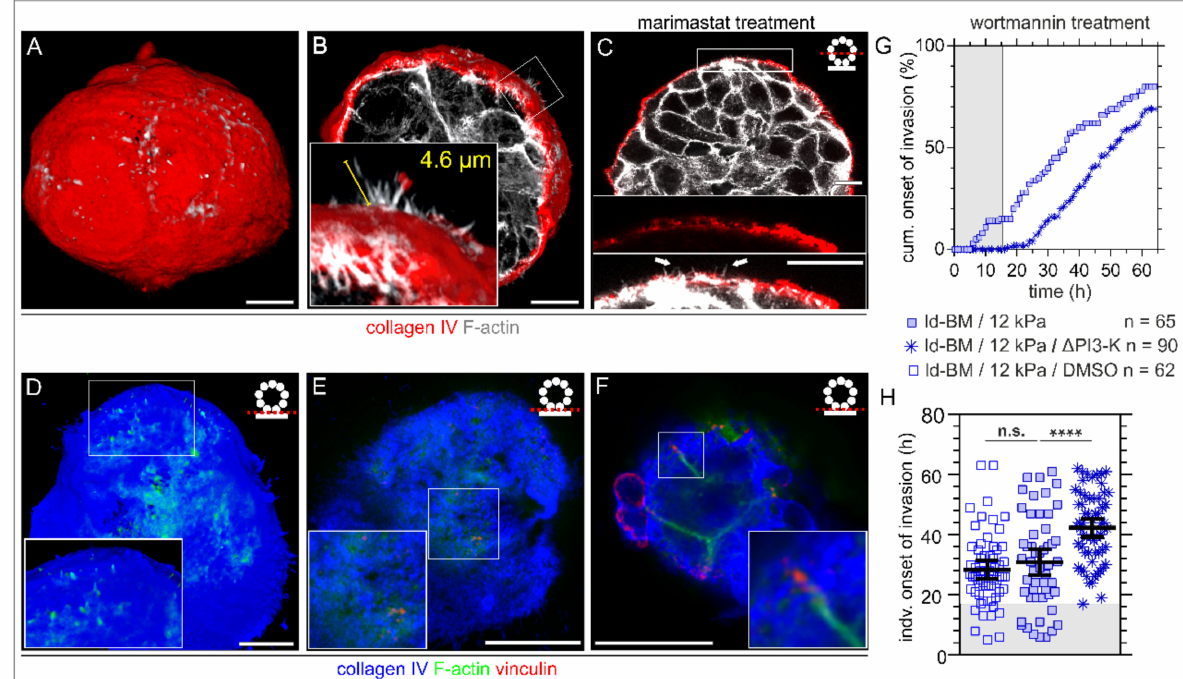
Figure 3. Formation of BM traversing actin protrusions and the impact of PI3-kinase inhibition on cell invasion. MCF10A acini were fixed and IF-stained. ( A ) 3D reconstructed confocal image stack demonstrating BM (collagen type IV, red) penetrating actin-based protrusions (F-actin, white) formed in physiological conditions within EHS matrix (fully matured hd-BM acinus after 31 days). ( B ) 3D cross-section through an hd-BM acinus with BM (red)-piercing F actin-rich protrusions (white) for proinvasive conditions (+EGF, 24 h on glass) including length measurement (yellow). ( C ) 2D cross-section of a marimastat treated ld-BM acinus (+EGF, 24 h on glass), indicating the formation of actin-rich protrusions (white arrow heads) piercing collagen type IV pores of the BM. ( D ) Rendered 3D image stack shows the acini–BM–substrate interface before